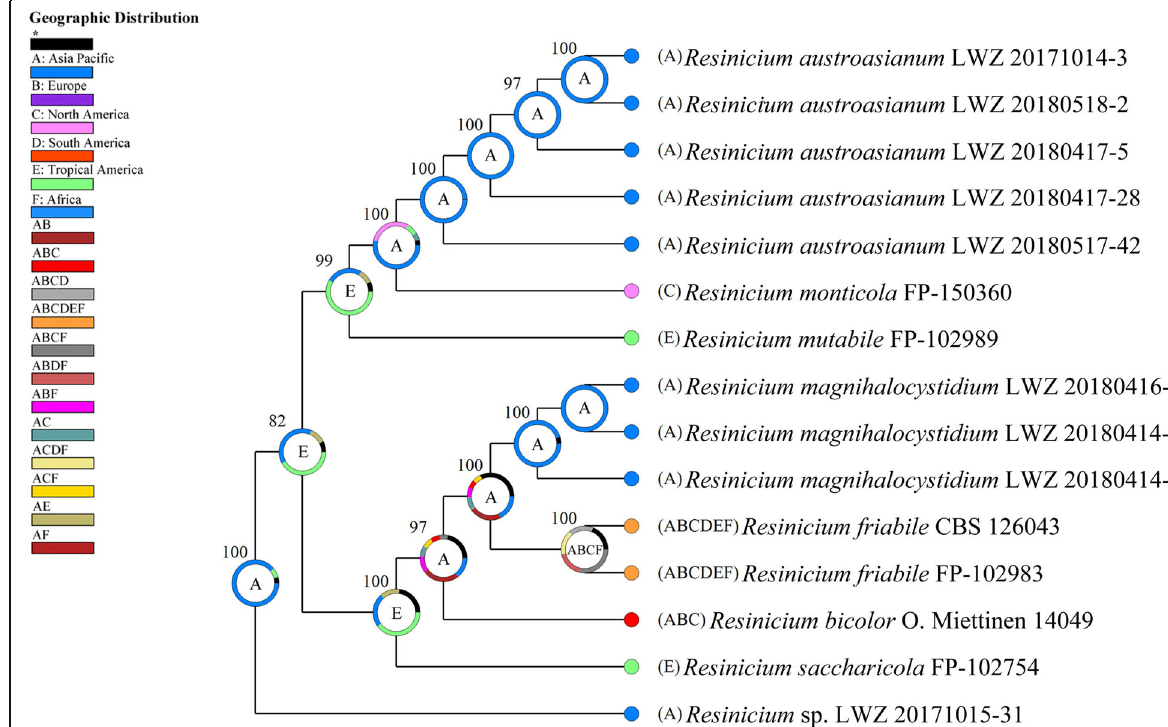
Fig. 3 Biogeography of Resinicium inferred from the combined dataset of ITS and nLSU regions. The midpoint-rooted consensus tree was generated by the Bayesian inference method using BEAST. As evaluated using RASP under the Bayesian Binary MCMC analysis, the geographic origin was indicated by a pie chart at each node of the tree. The geographic distribution represented by each color and letter in the pie charts and the illustration is indicated in the upper left of the tree